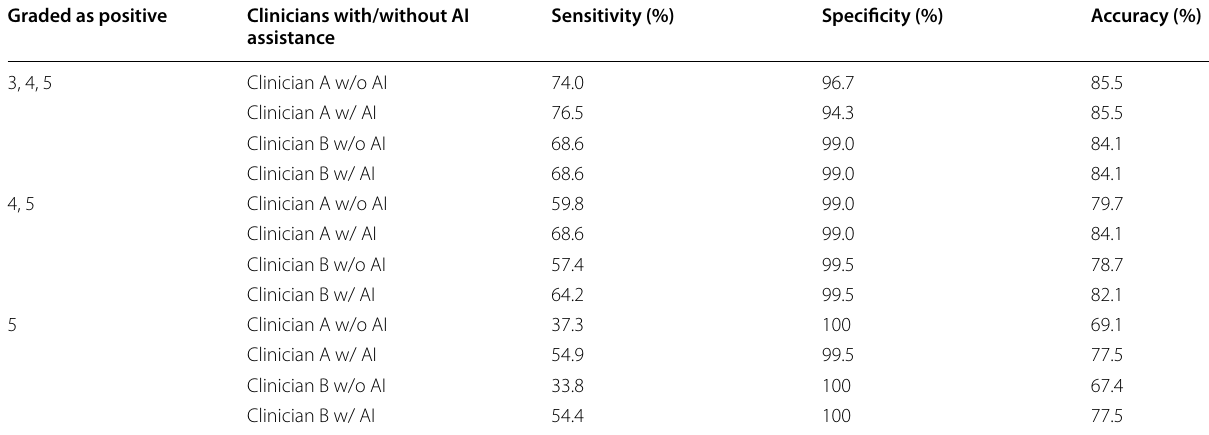
Table 3 The side-based sensitivity, specificity, and accuracy values of the human (clinicians’) diagnoses and AI-assisted diagnoses on the 414 samples Graded as positive